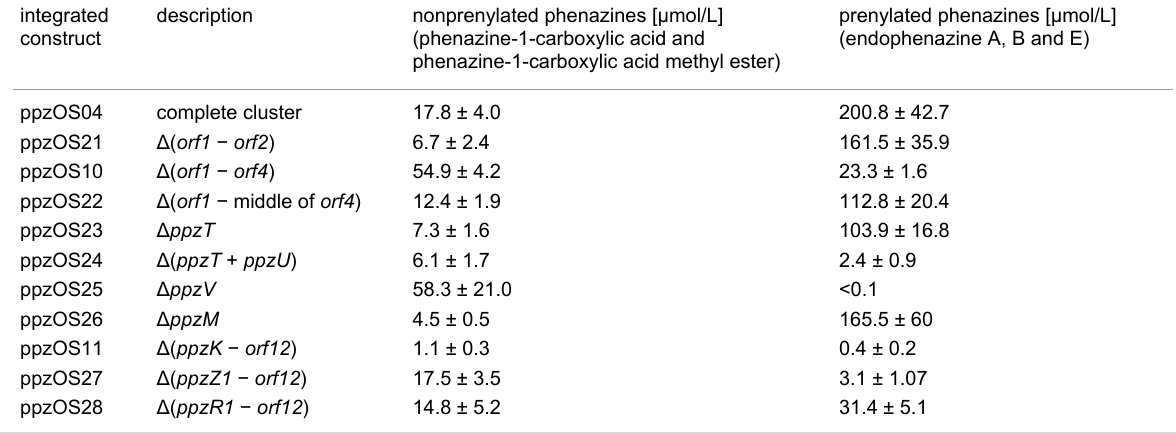
Table 3: Production of nonprenylated and of prenylated phenazines in the heterologous expression strain Streptomyces coelicolor M512, carrying either the complete endophenazine gene cluster (ppzOS04) or clusters in which individual genes had been deleted. Data represent mean values ±SD. integrated